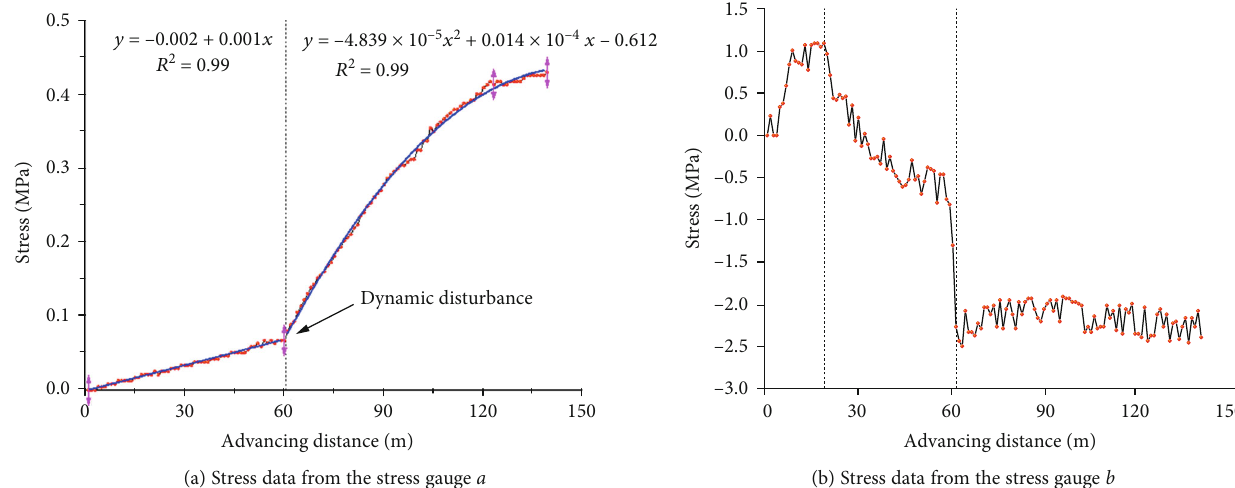
Figure 7: Stress fi eld evolution in similar physical